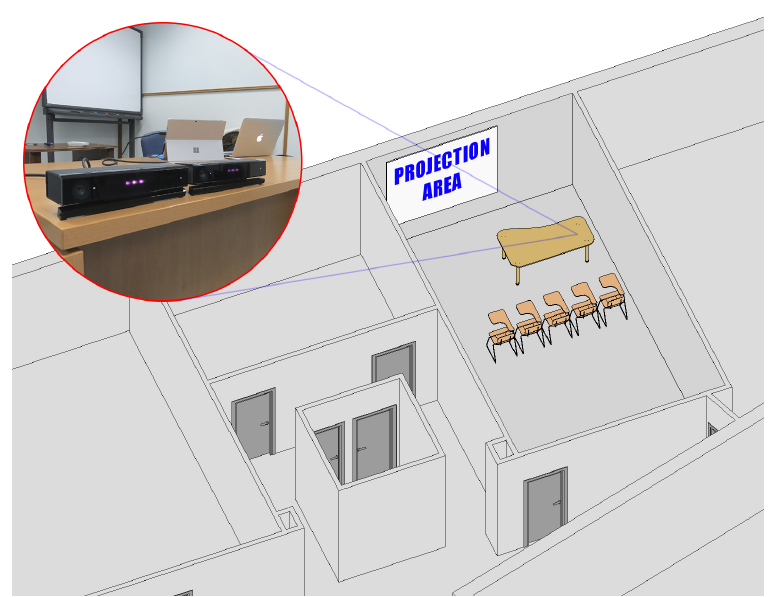
Figure 1. Arrangement of Kinect devices in the classroom. Space previously analyzed with BIM (Building Information Modelling)